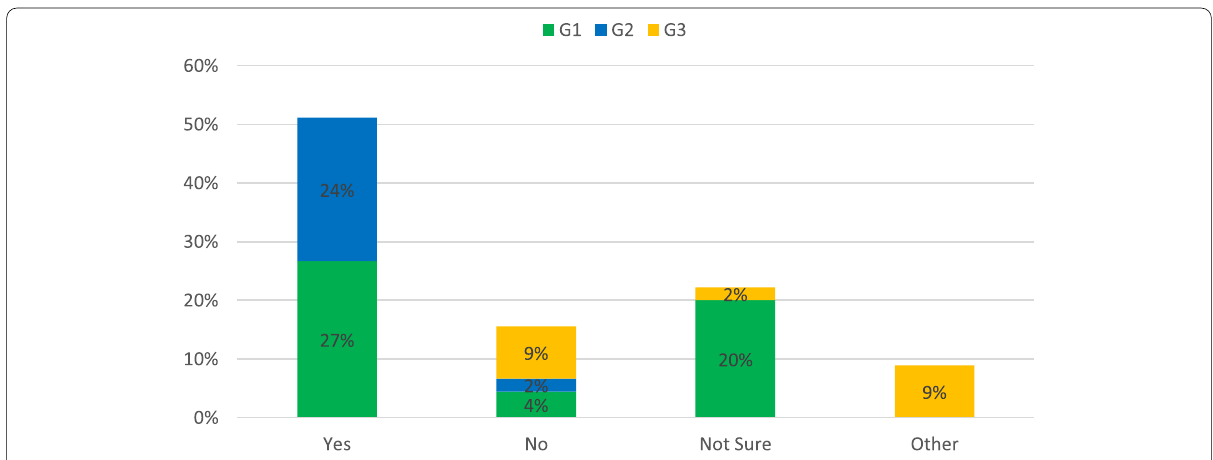
Fig. 8 Response to: Can investment in in roads providing public transport be prioritized whilst still maintaining transport